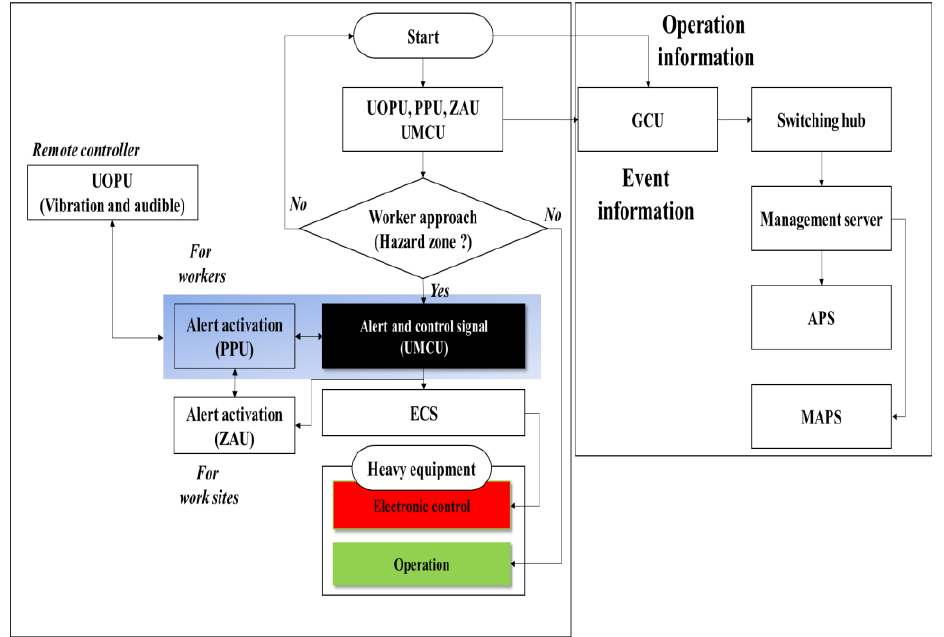
Figure 7. Operational scenario of UCAS and GPS-based resource management system (GRMS). Sensors 2019 , 17 , x FOR PEER REVIEW